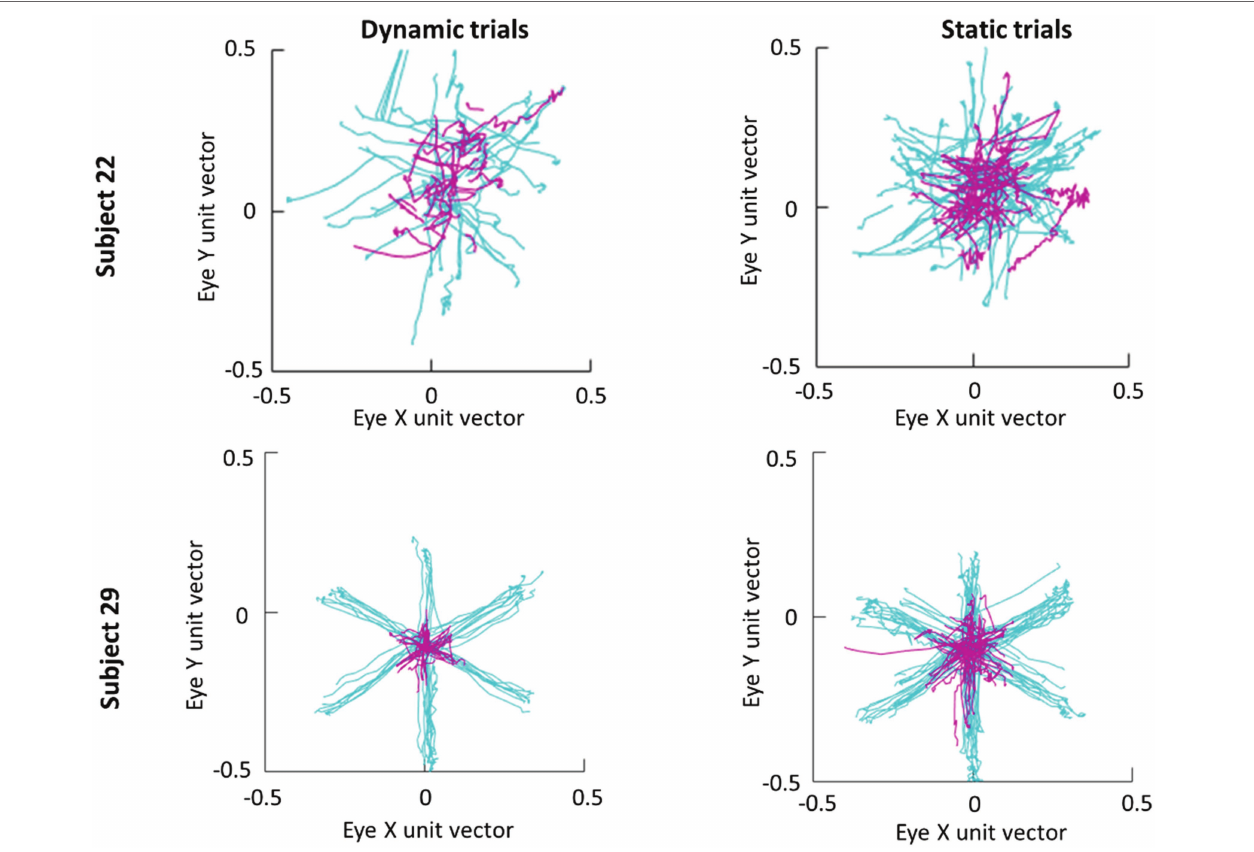
FIGURE 3 | Scan paths of first saccade made in each trial for subjects 22 (top row) and 29 (bottom row). Trials where the cue appeared in the parafovea and periphery are plotted in magenta and cyan,